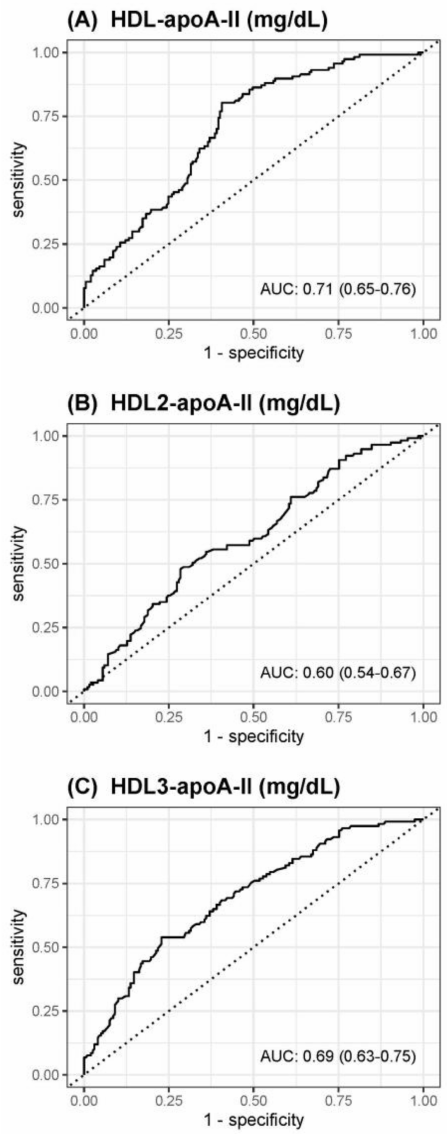
Figure 2. Receiver operating characteristics curves for prediction of death within 1 year of ( A ) HDL- apoA-II, ( B ) HDL2-apoA-II, or ( C )